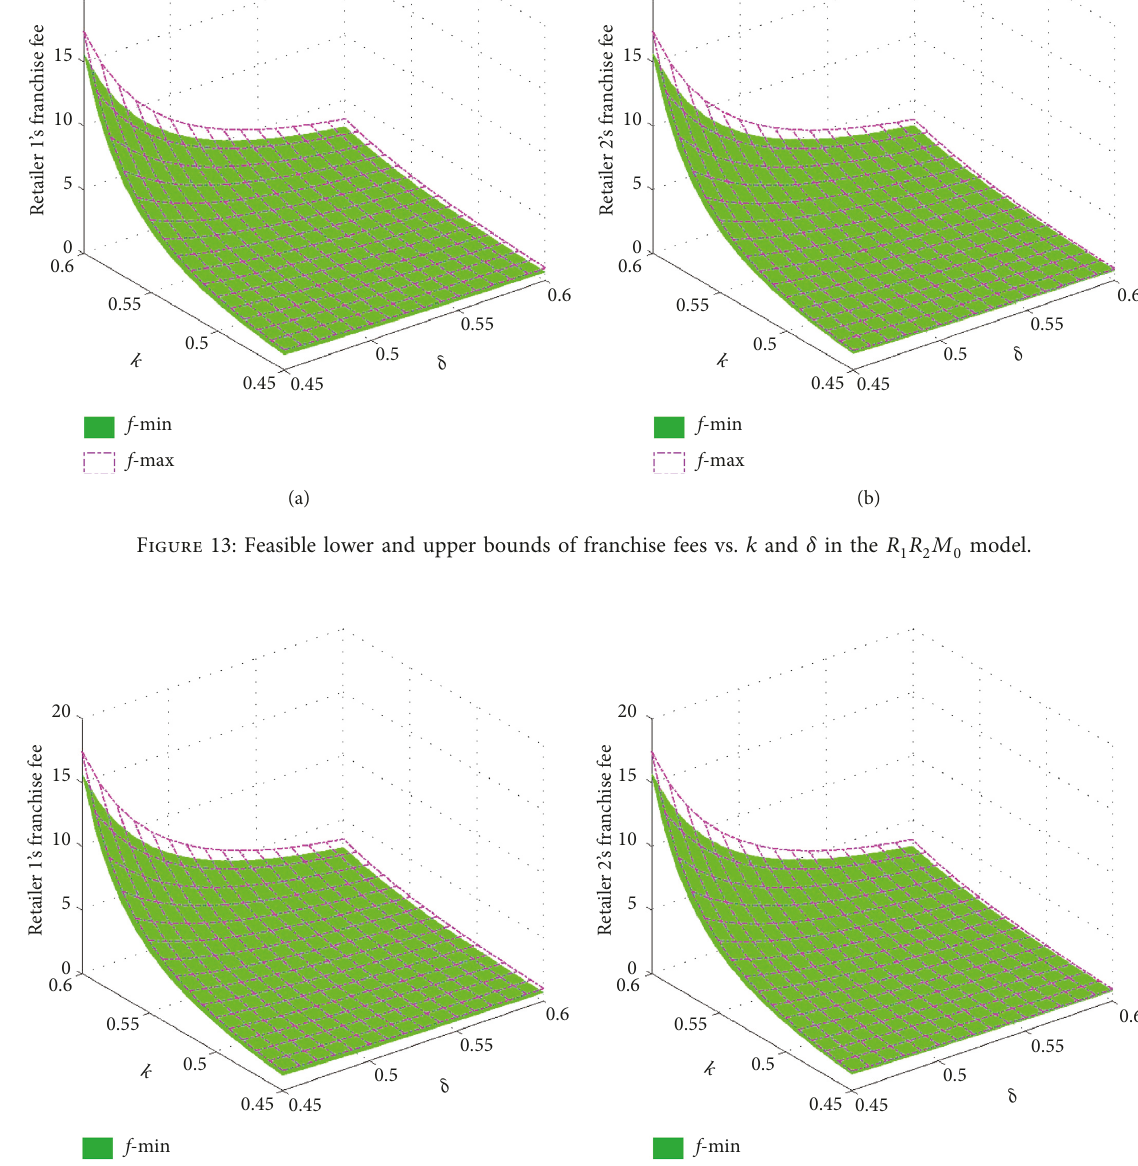
Figure 14: Feasible lower and upper bounds of franchise fees vs. k and δ in the VS